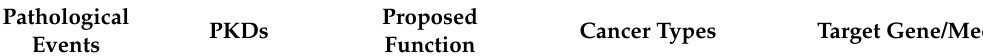
Table 1. Contributary roles of PKD isoforms in